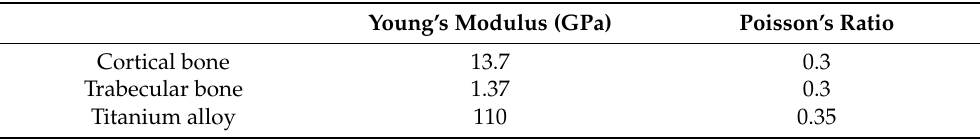
Table 1. The material properties used for the finite element